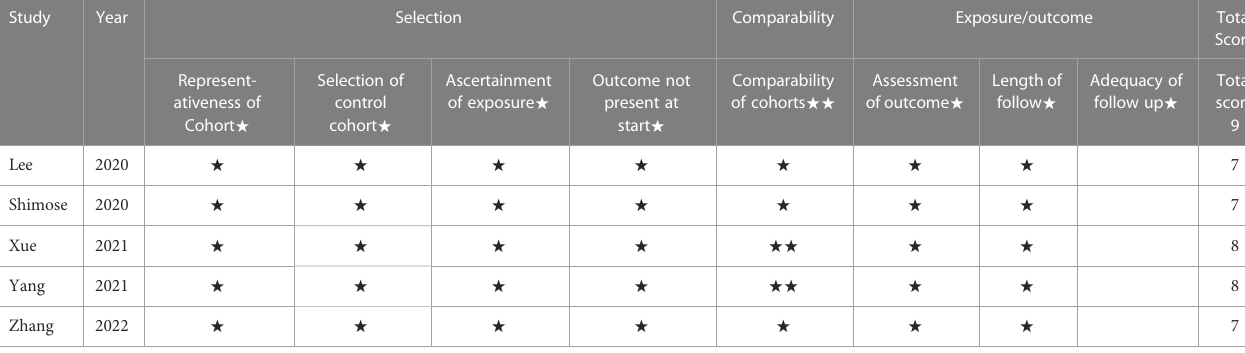
TABLE 3 Assessment of cohort studies using Newcastle – Ottawa scale. Study